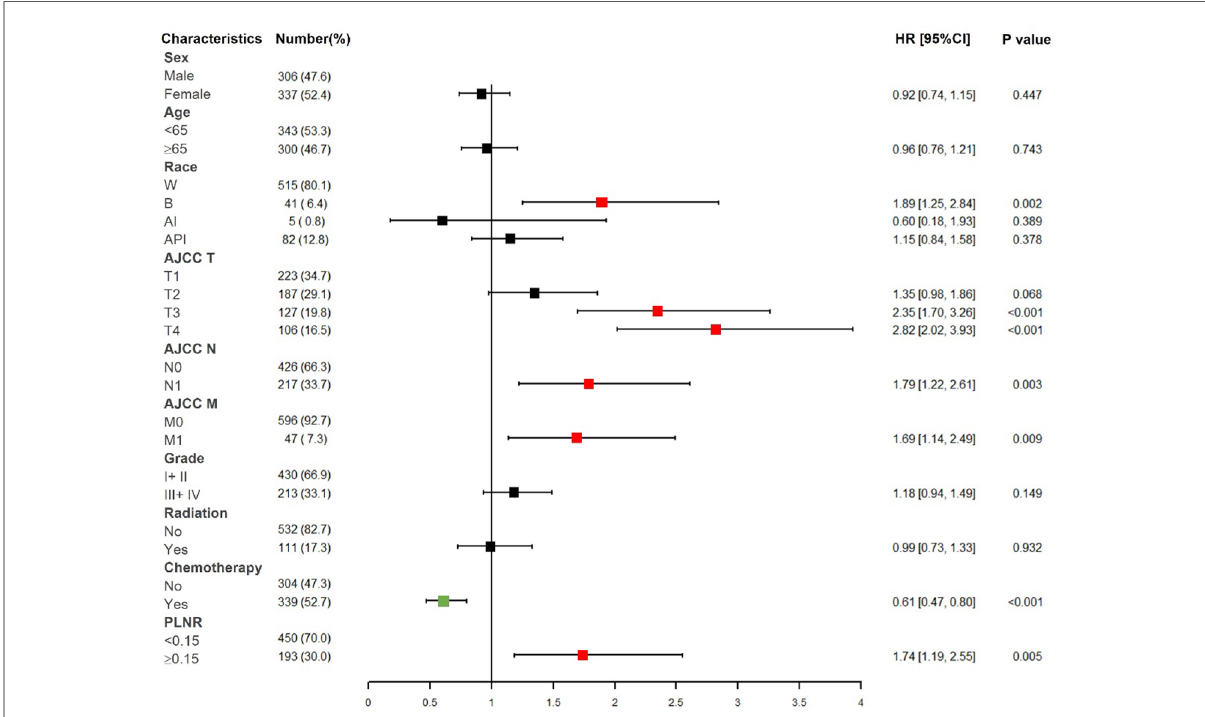
FIGURE 2 Forest plot of multivariate cox regression analysis for CSS in patients with ICC after hepatectomy. W, White; B, Black; AI, American Indian/Alaska native; API, Asian or Paci fi c Islander; PLNR, positive lymph node